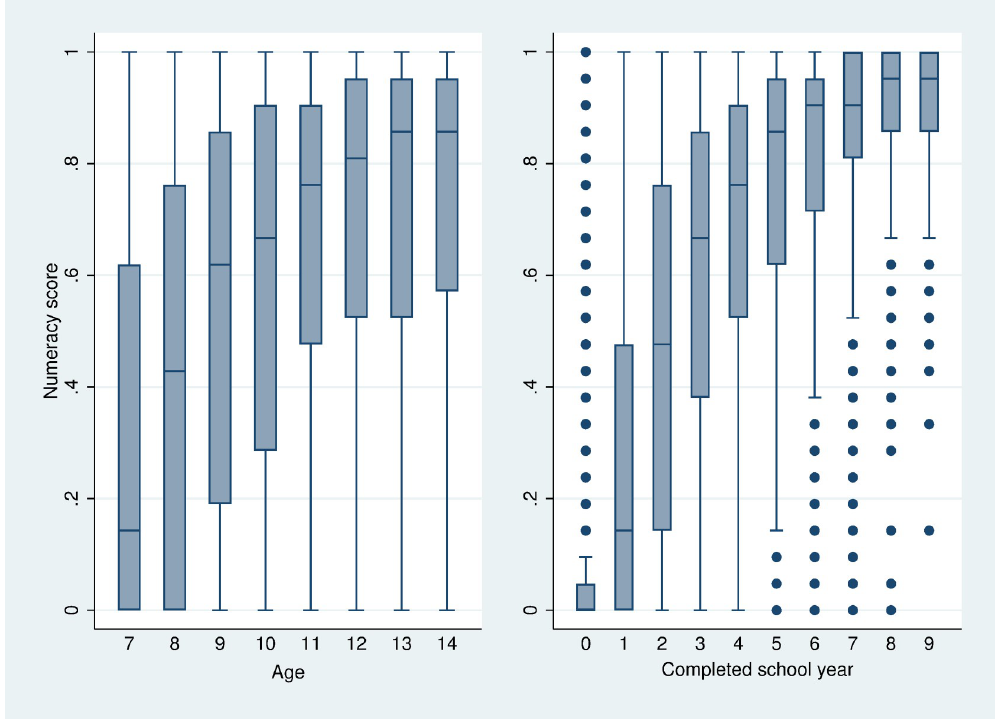
Fig 2. Numeracy test scores by children’s age or by completed school years (median, 25 th and 75 th percentile).